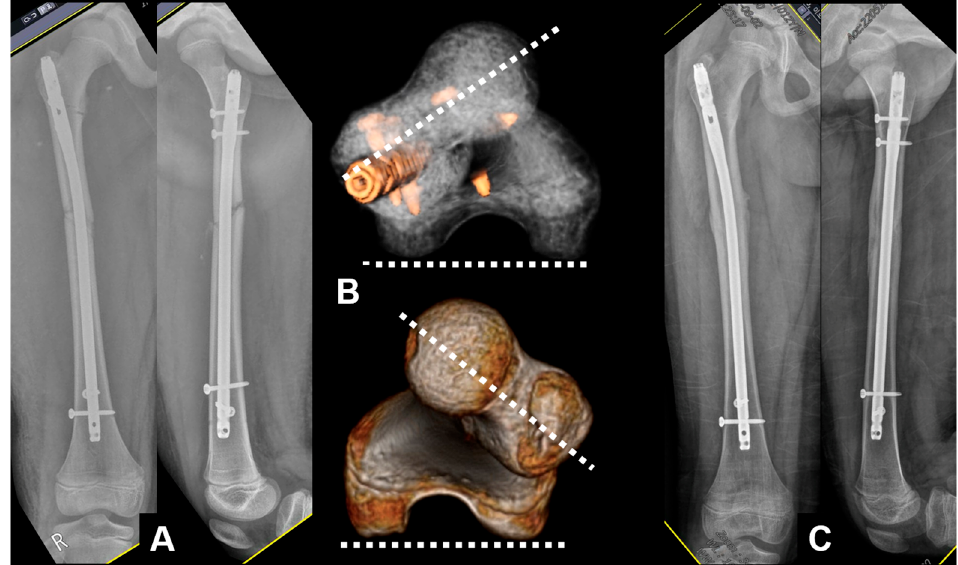
Figure 6. ( A ) Postoperative radiographs showing revised fixation of distal interlocking; ( B ) CT scan showing similar angles of anteversion; ( C ) complete healing observed 6 months postoperatively.